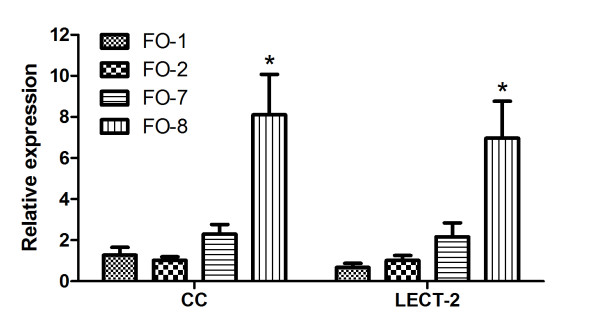
Cellular signaling and chemotaxin markers expressed in the head kidney of Atlantic salmon injected with different oil-based vaccines. qPCR expression studies of chemokine (CC) and leukocyte cell derived chemotaxin 2 (LECT 2) genes identified as upregulated by microarray. FO-1 = A. salmonicida (sc); FO-2 = A. salmonicida (6 × sc); FO-7 = M. viscosa (sc); FO-8 = M. viscosa (6 × sc). Gene expression ratios normalized to EF1α. Error bars = SE, n= 7. *p < 0.05.